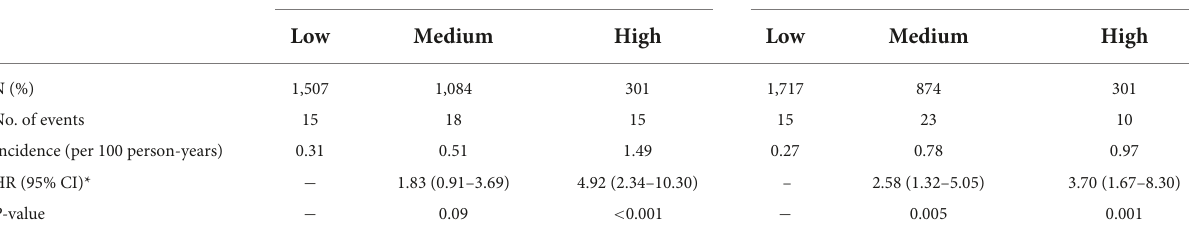
TABLE 2 Major bleeding incidence and Cox proportional-hazards regression analysis of risk levels stratified by the ABC-bleeding and the modified HAS-BLED scores. ABC-bleeding score risk